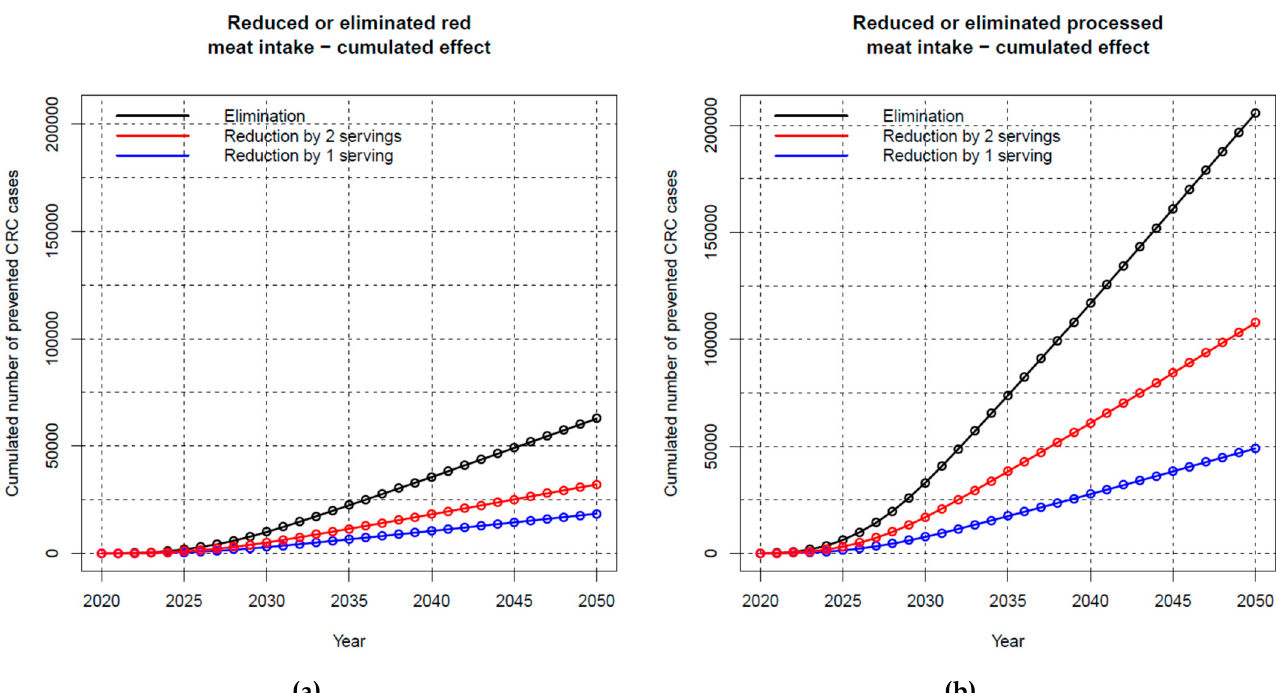
Figure 2. Cumulative prevented colorectal cancer cases over time in case of a reduction in ( a ) red and ( b ) processed meat consumption (men and women combined). Abbreviations: CRC, colorectal cancer.